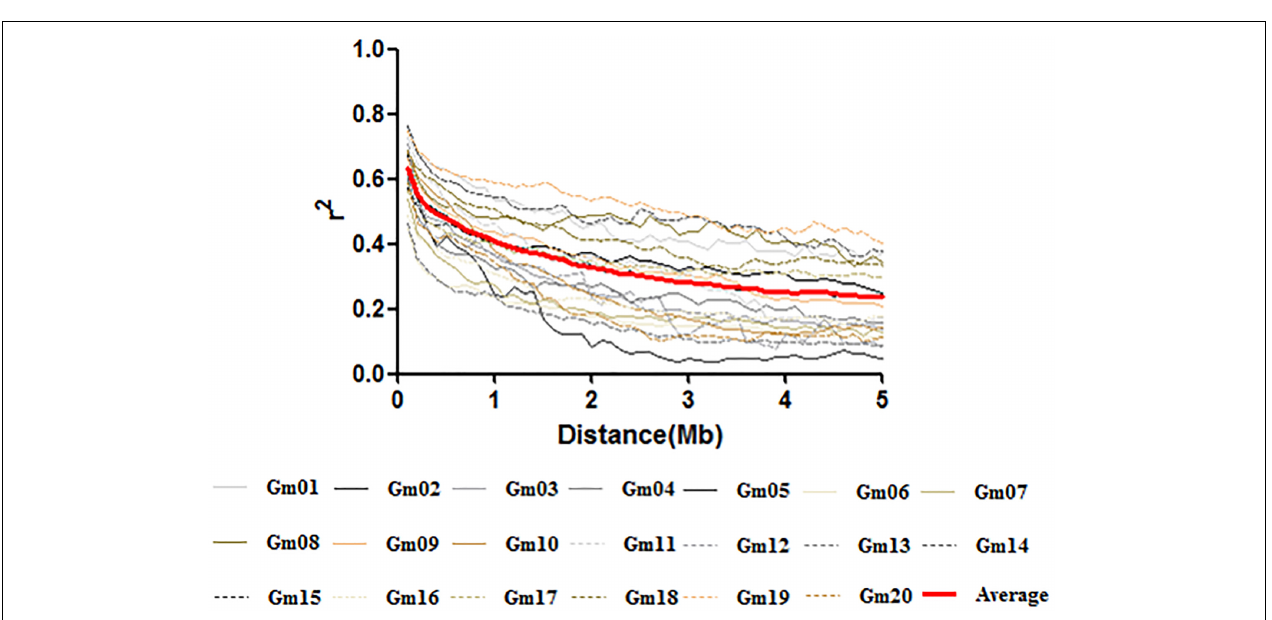
FIGURE 3 | Linkage disequilibrium decay plots across soybean chromosomes and the average decay across the genome.